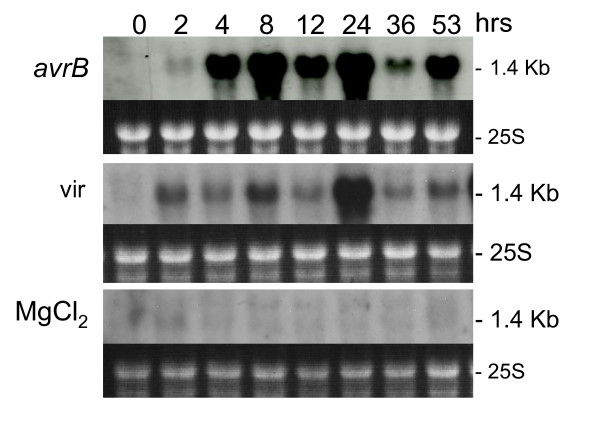
Chalcone synthase (CHS) RNA (1.4 kb) profile. Measurements made at 8 intervals through a 53 hr period in response to infection by Pseudomonas syringae pv glycinea with avrB (avrB) or without (vir) (First and second panels respectively). Third panel is the CHS RNA profile in response to infiltration with control medium (MgCl2). Dark background sub-panels are the 25 S ribosomal RNAs from corresponding ethidium bromide-stained gels prior to membrane transfer and shown to compare sample loading. The soybean CHS genomic clone (pC2H2.0, Gm-b10BB-5) was used as probe.